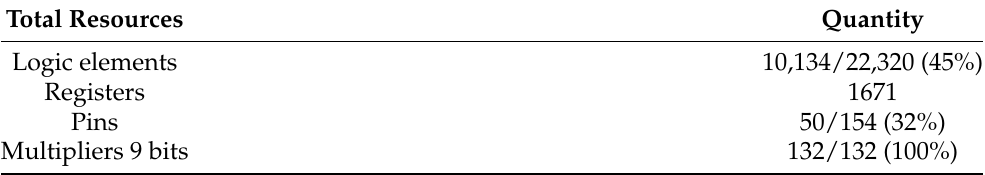
Table 2. Total resources of the hardware implementation and its